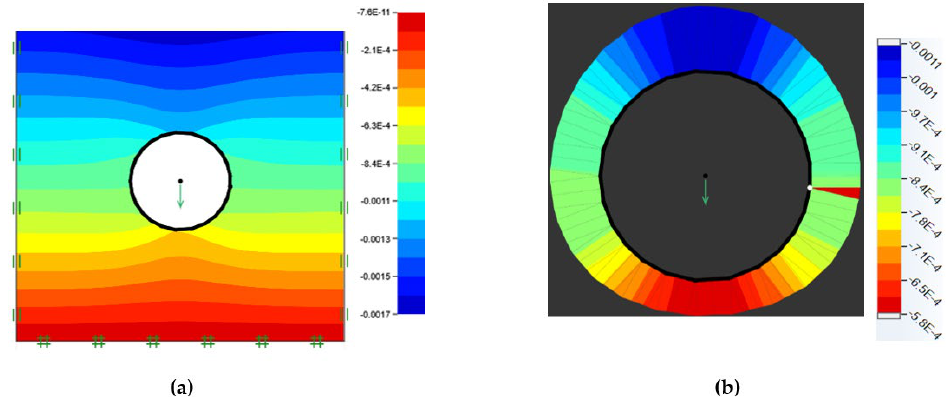
Figure 10. Vertical displacement contours for ( a ) soil mass and ( b ) aluminium lining.